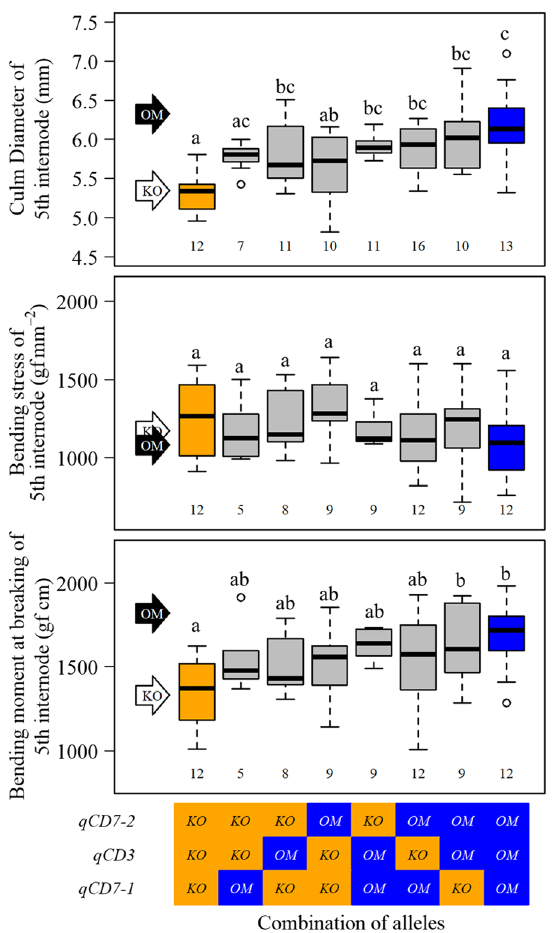
Fig. 4 Comparison of the culm traits of the RILs classified on the basis of allele combinations. White and black arrows indicate the trait values of Koshihikari and Omachi, respectively. In boxplots, different letters indicate significant differences at p < 0.05 (Tukey’s test). The number under each boxplot indicates the number of RILs classified into the